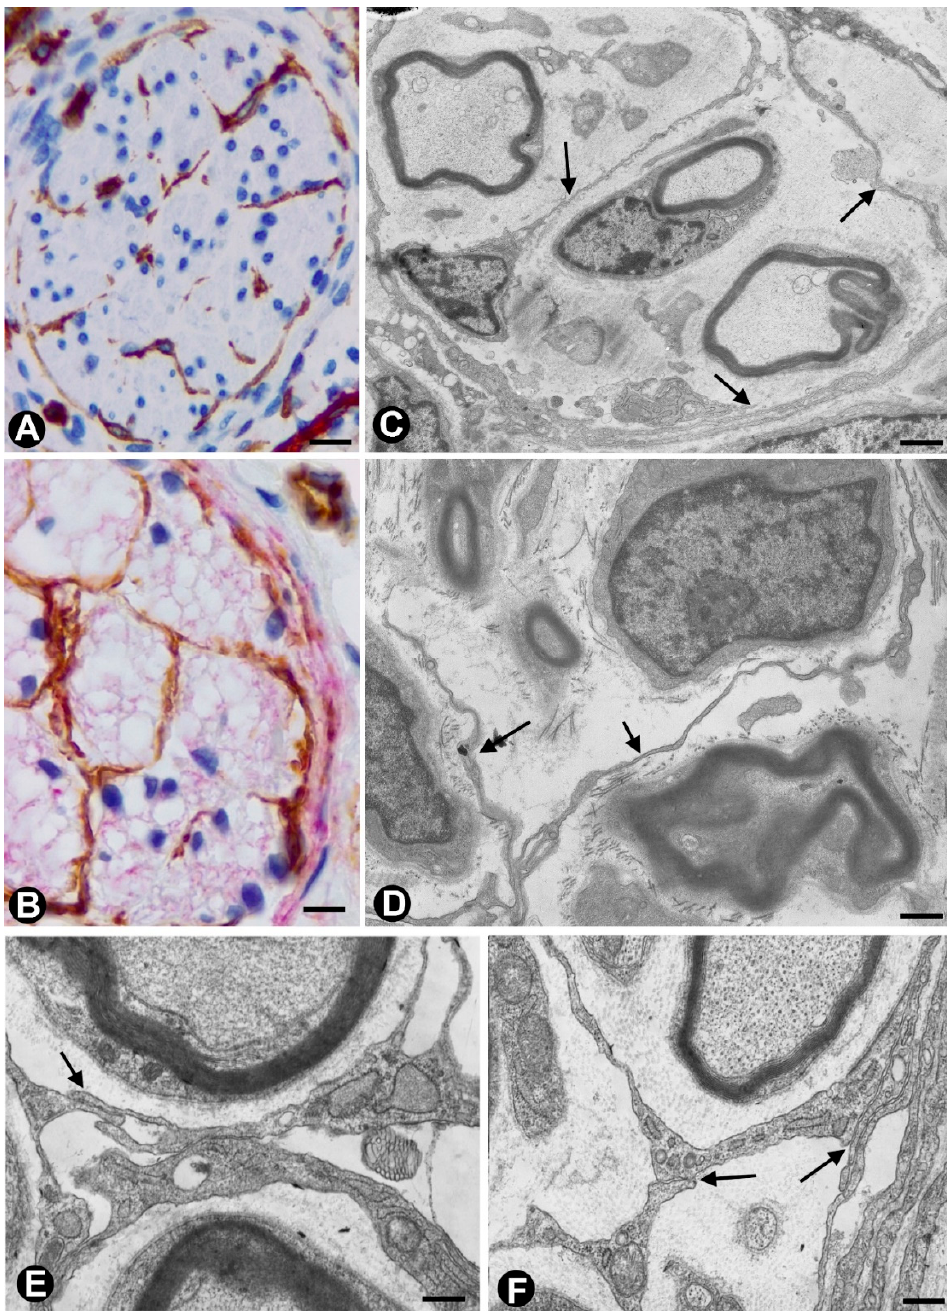
Figure 1. In peripheral nerves, telocytes (TCs) / CD34 + SCs are observed in the epi-perineurium and endoneurium under light ( A , B ) and electron microscopy ( C – F ). It should be noted that in B, the TCs (brown) are arranged, underlying the perineurial cell layer (perineurial cells: red) in the epi-perineurium. C–F: Ultrastructural characteristics of endoneurial TCs, in which long, thin telopodes (C and D, arrows) and homocellular junctions (E and F, arrows) are seen. A and B: sections immunostained with anti-CD34 (A), and double-immunostained with anti-CD34 (brown) and epithelial membrane antigen (EMA) (red) (haematoxylin-stained nuclei). C–F: Ultrathin sections. Uranyl acetate and lead citrate. Bar: A, 60 µ m; B, 40 µ m; C, 2 µ m; D, E, F, 1 µ m.